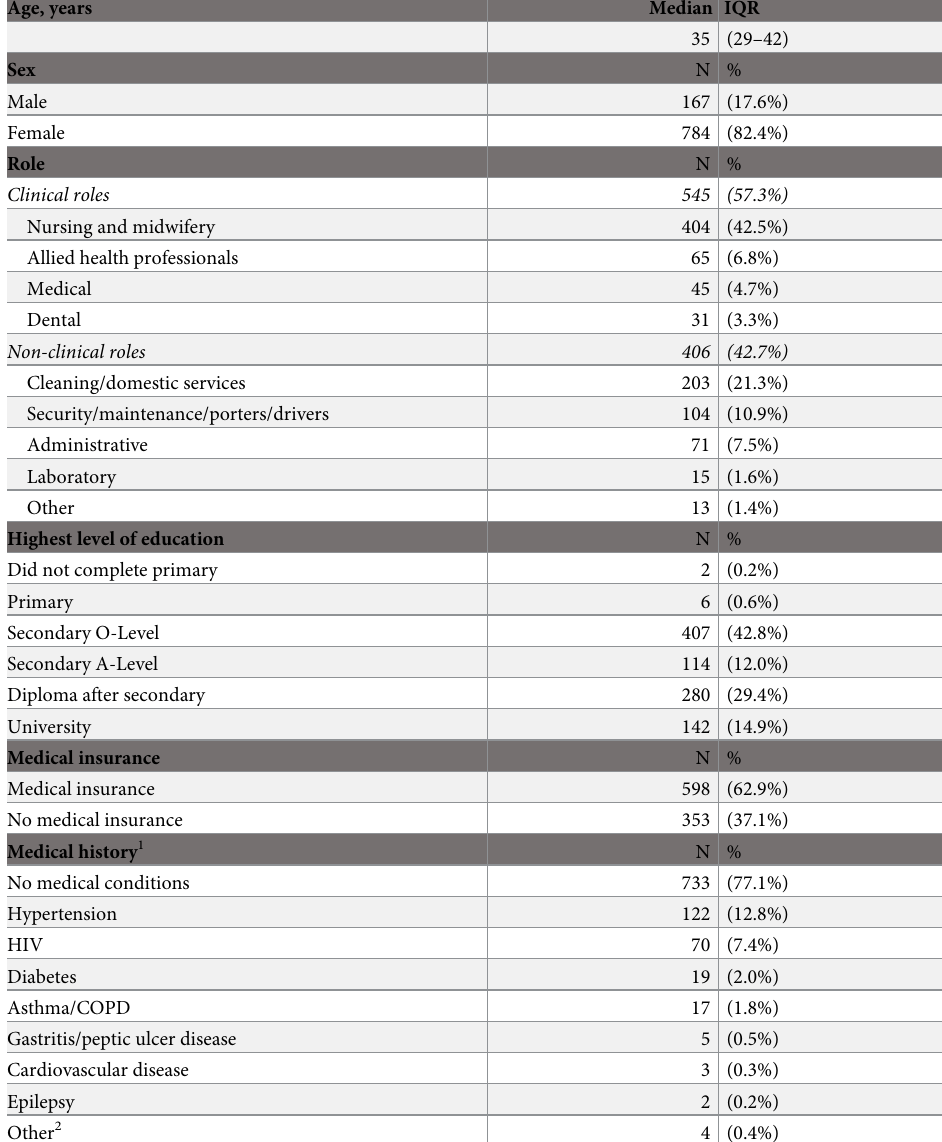
Table 1. Characteristics of 951 enrolled healthcare